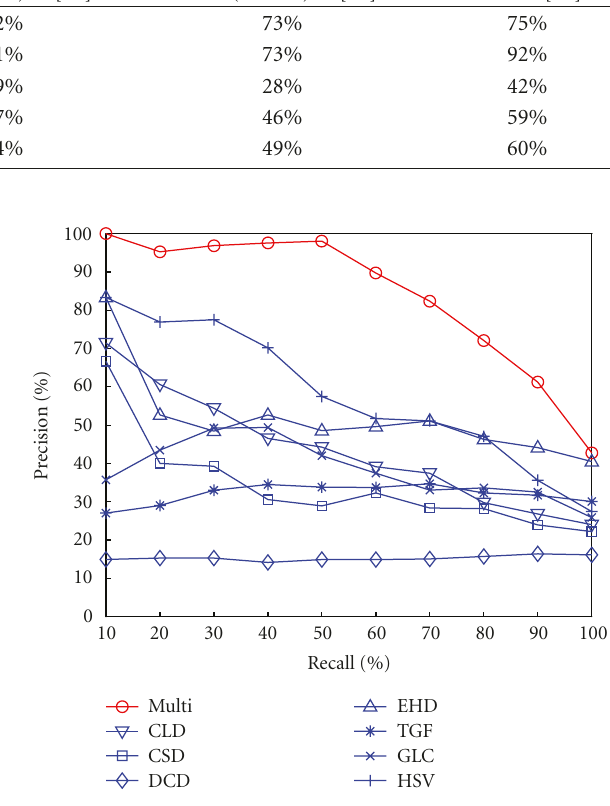
Figure 11: Precision-recall curves for concept lion using the multi- feature combination metric and using single